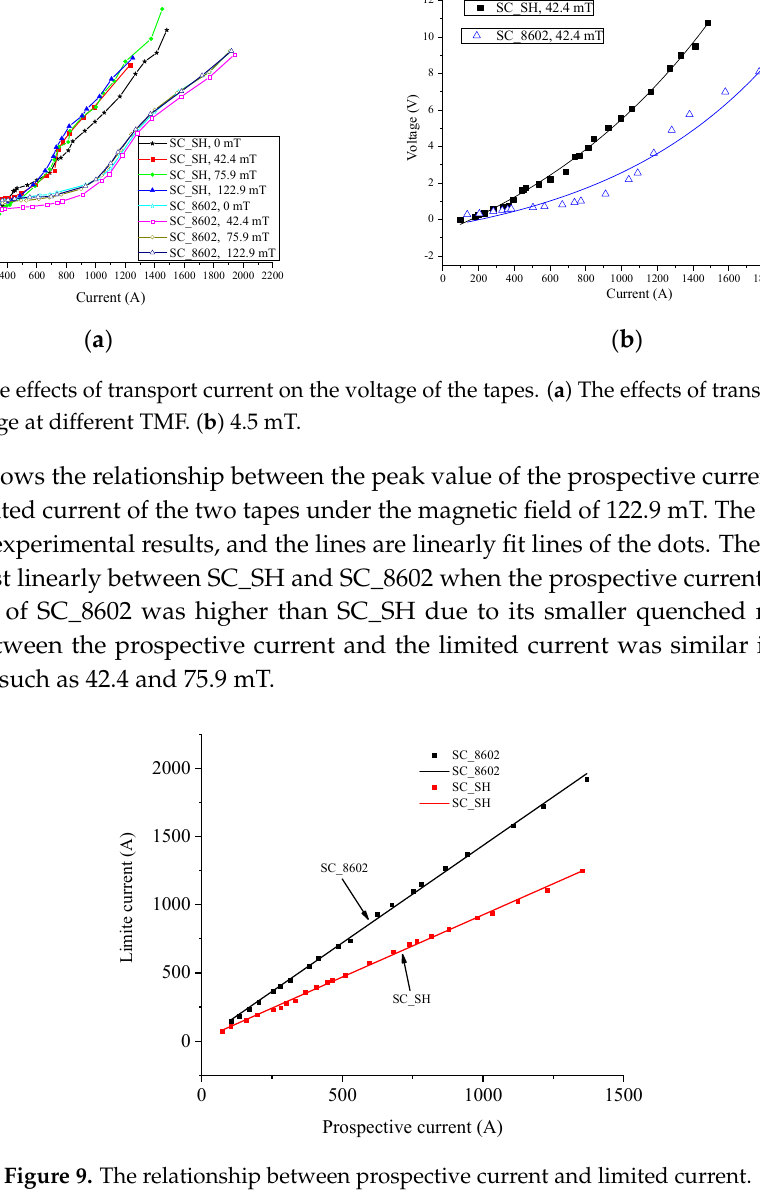
Figure 9. The relationship between prospective current and limited current.